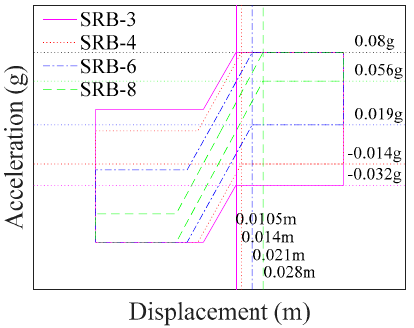
Figure 4. Hysteresis loops of four different SRB models with the same horizontal acceleration control